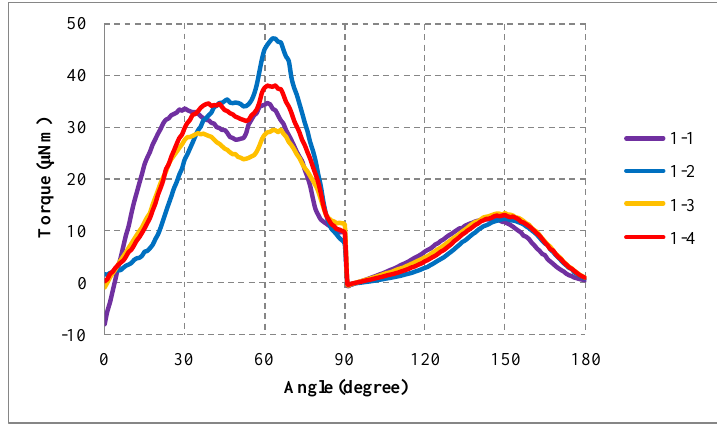
Figure 4. Step 1: Torque-angle curve for each step.